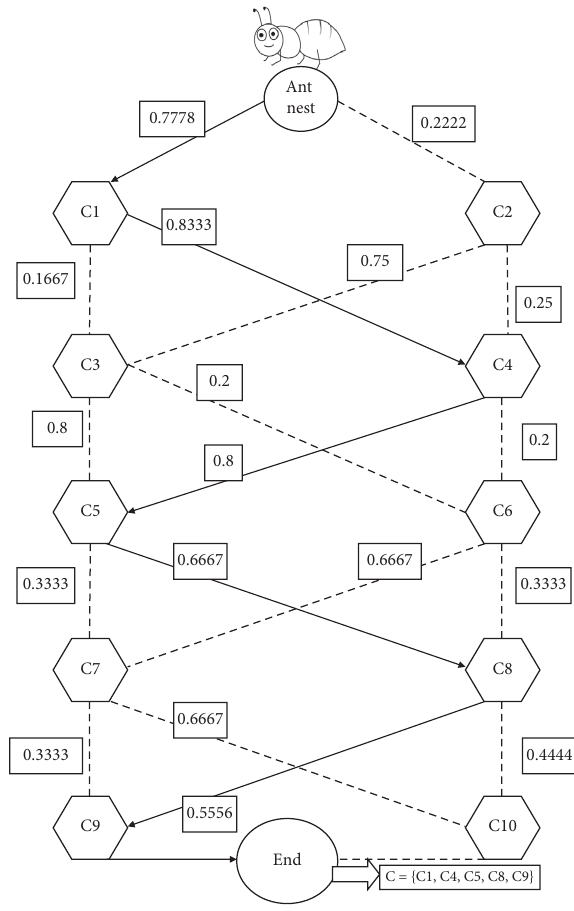
Figure 4: Pheromones probability wise path